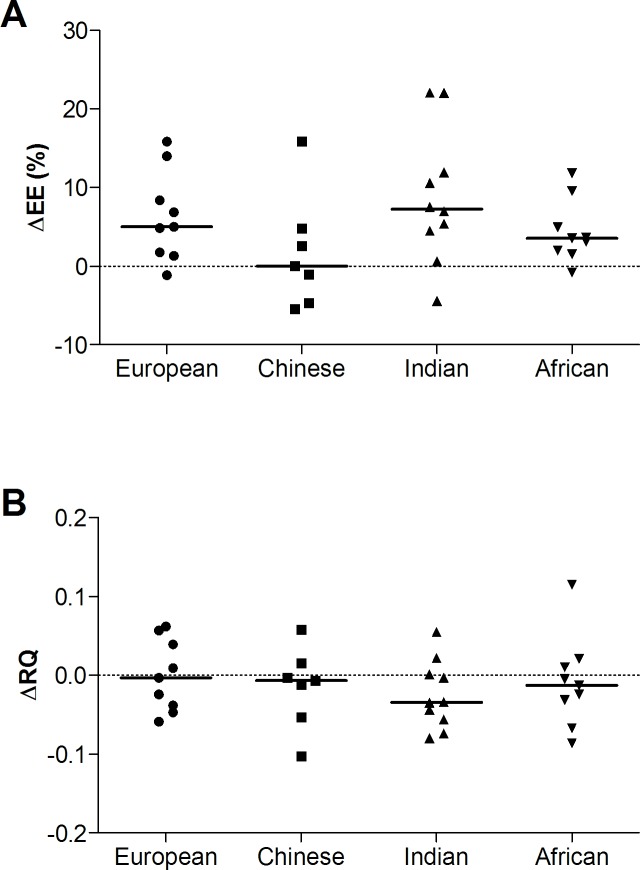
Individual energy expenditure (EE; Panel A) and respiratory quotient (RQ; Panel B) responses to standing compared to sitting (subjects grouped by ethnicity). ΔEE is calculated as the change in EE during the second 5 min of the standing period compared to sitting and expressed as a percentage of resting EE. Solid line represents the median value for each ethnic group.